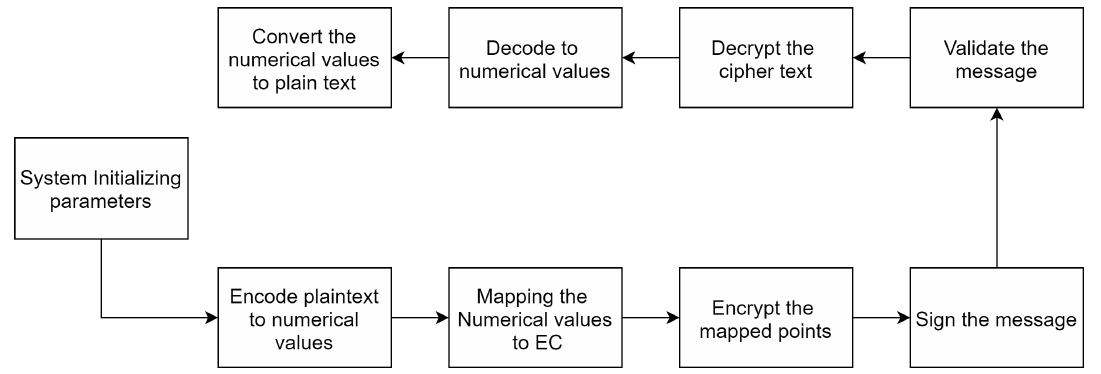
Figure 2. High-level overview of proposed